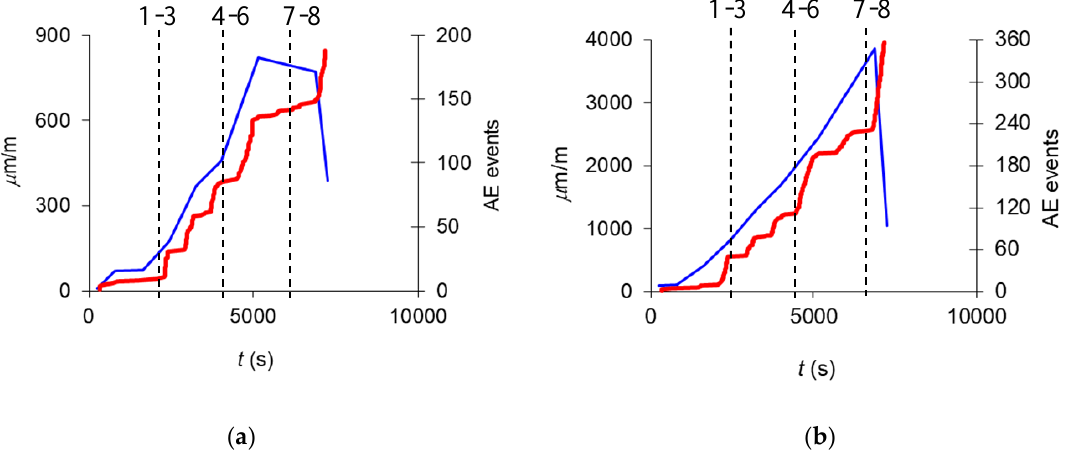
( b ) Figure 13. Cumulative AE activity and FOS strain time histories for: ( a ) fiber optic n.7 at x = − 1.6 m and AE sensor n.0; ( b ) fiber optic n.7 at x = − 1.2 m and AE sensor n.1. The dashed lines identify the different loading stages. 8.2. Cracks Pattern The results of FOS and AE monitoring are compared with the actual pattern of cracks directly observable in the laboratory. Figure 14 shows the cracks at loading step #7 where the crack development at the bottom side of the beam can be noticed. Furthermore, the transition of crack